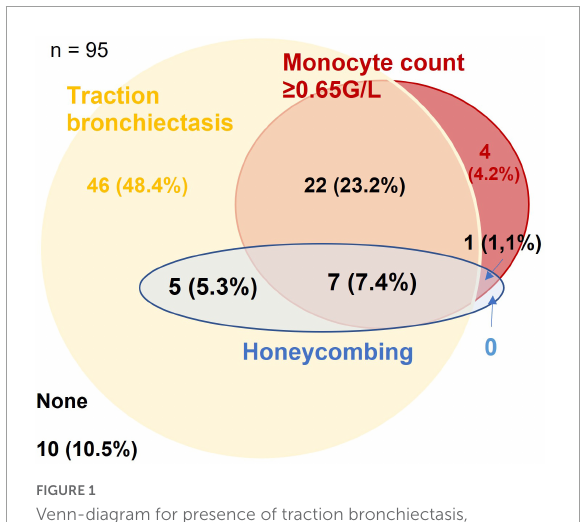
FIGURE1 Venn-diagram for presence of traction bronchiectasis, honeycombing, and monocyte count ≥ 0.65 G/L in the derivation cohort. Figures are given as n (% of the cohort).